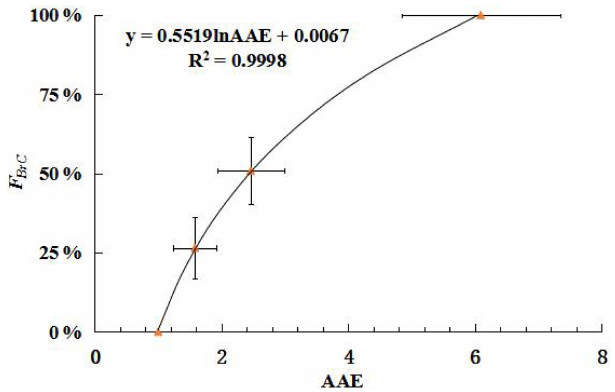
Figure 5. Relationship between F BrC and